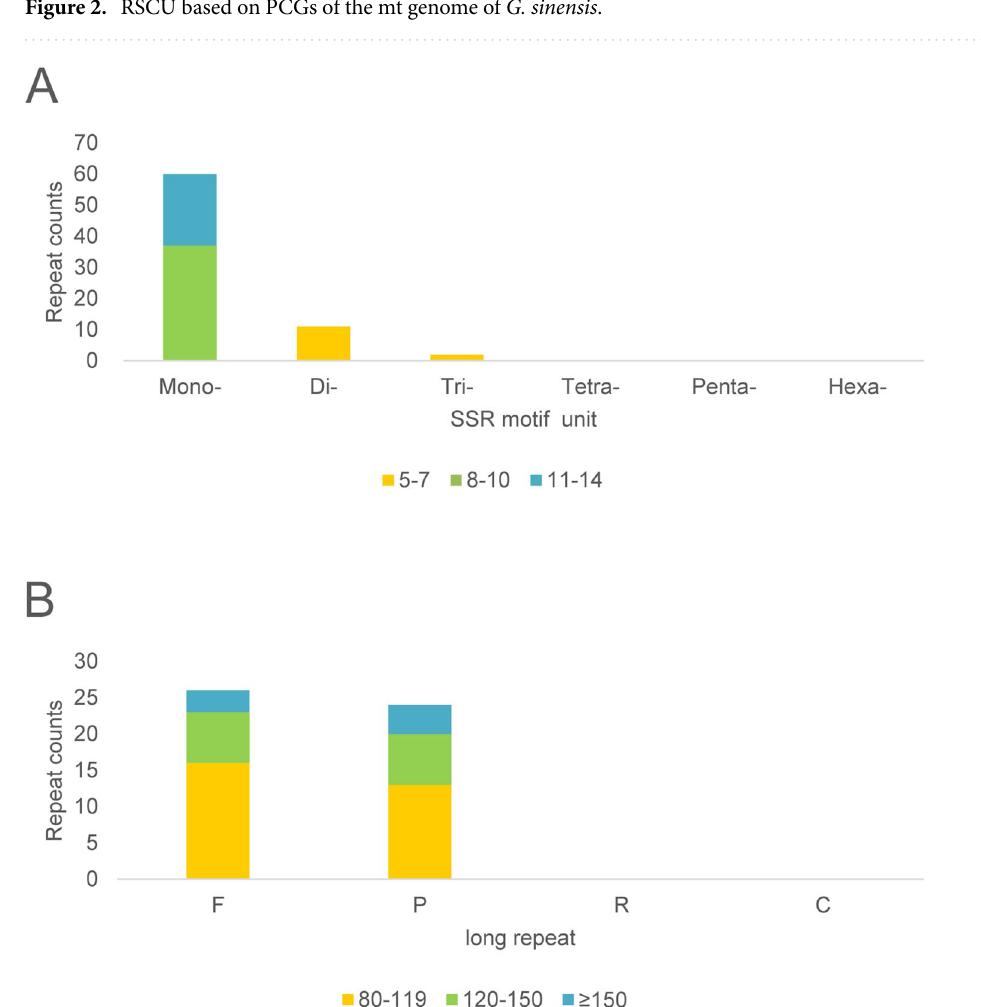
Figure 3. Analyses of repeats in the G. sinensis mt genome. ( A ) The number of different types of SSRs. ( B ) The number of different types of long